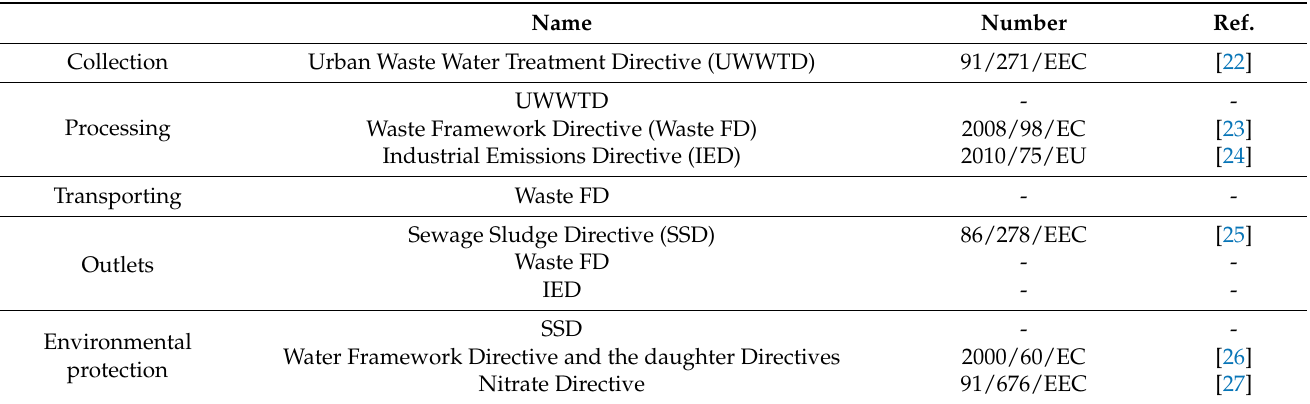
Table 1. Overview of EU legislation relating to MWW and